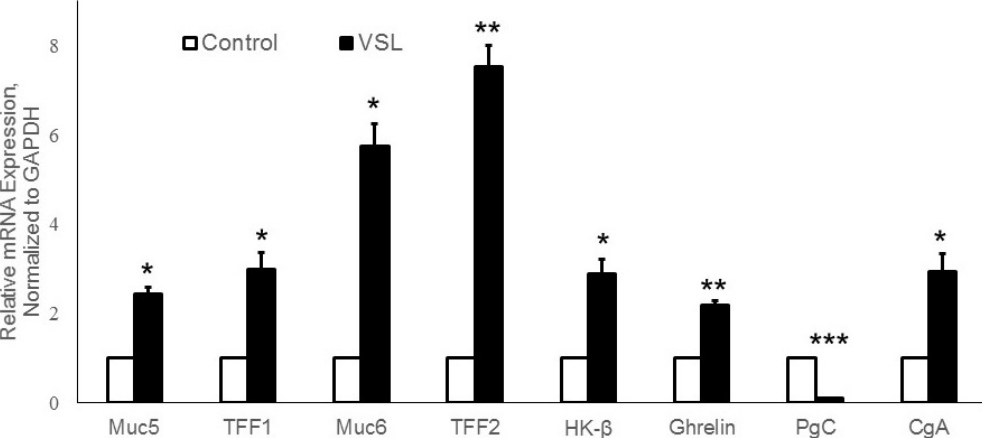
Figure 12. Quantitative RT-PCR analysis of mRNA expression of VSL–treated tissues versus control tissues. Expression of TFF1, TFF2, Muc5ac, Muc6, H + ,K + -ATPase β subunit, ghrelin, CgA and PgC in VSL and control tissues were compared. Data from three di ff erent pairs of control and VSL-treated mice were presented as mean ± SE and normalized to GAPDH. The asterisks indicate significant di ff erences from the control group. * p < 0.05; ** p < 0.01; *** p < 0.001.